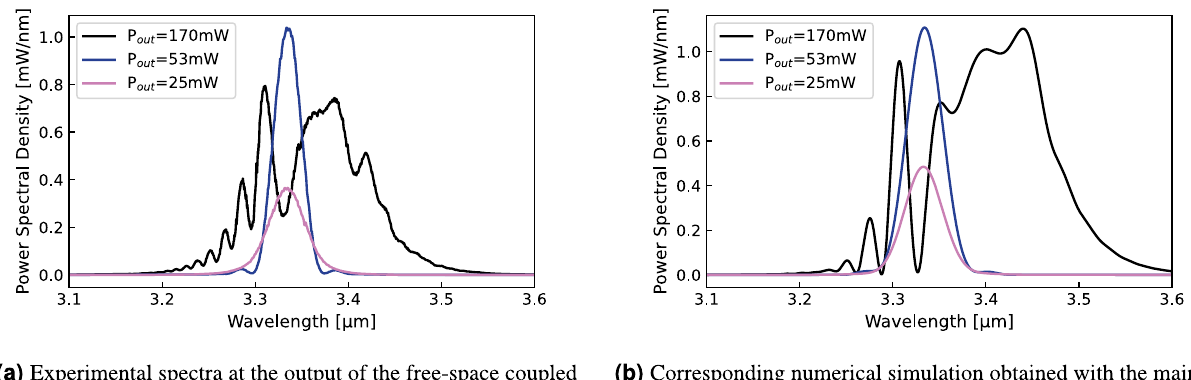
Figure 10. Adding neutral optical density (OD) filters before the InF 3 fiber allows to demonstrate the interference effect between the main soliton and its remnants arising as the input power is increased. P out corresponds to the spectrally integrated output power over 3.1–3.8 μm.